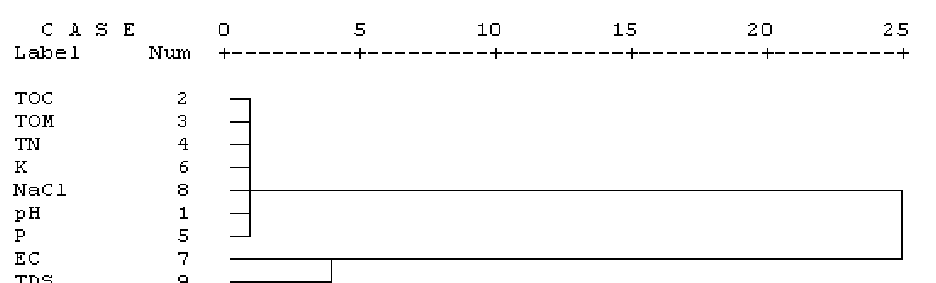
Fig. 4: Hierarchical cluster analysis